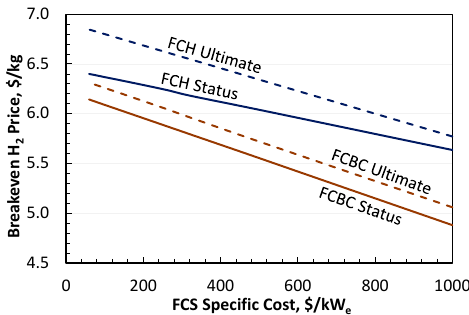
Figure 10. Sensitivity of breakeven H 2 price to FCS-specific cost relative to USD 3.25/gal diesel and an ESS cost of USD 157/kWh (solid lines) and USD 80/kWh (dashed lines).